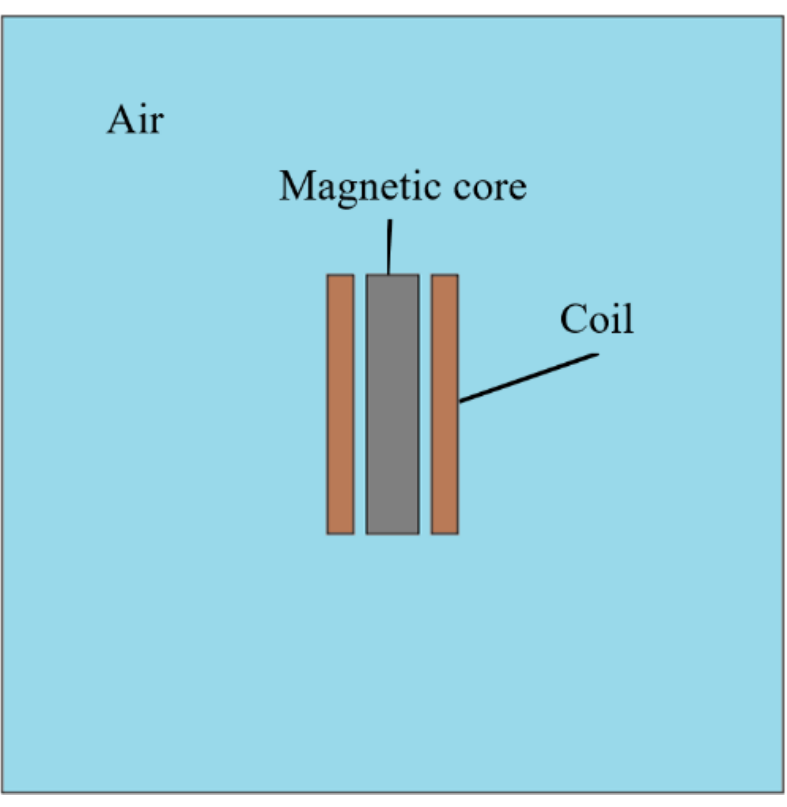
Figure 5. Model of the inductor with magnetic core.